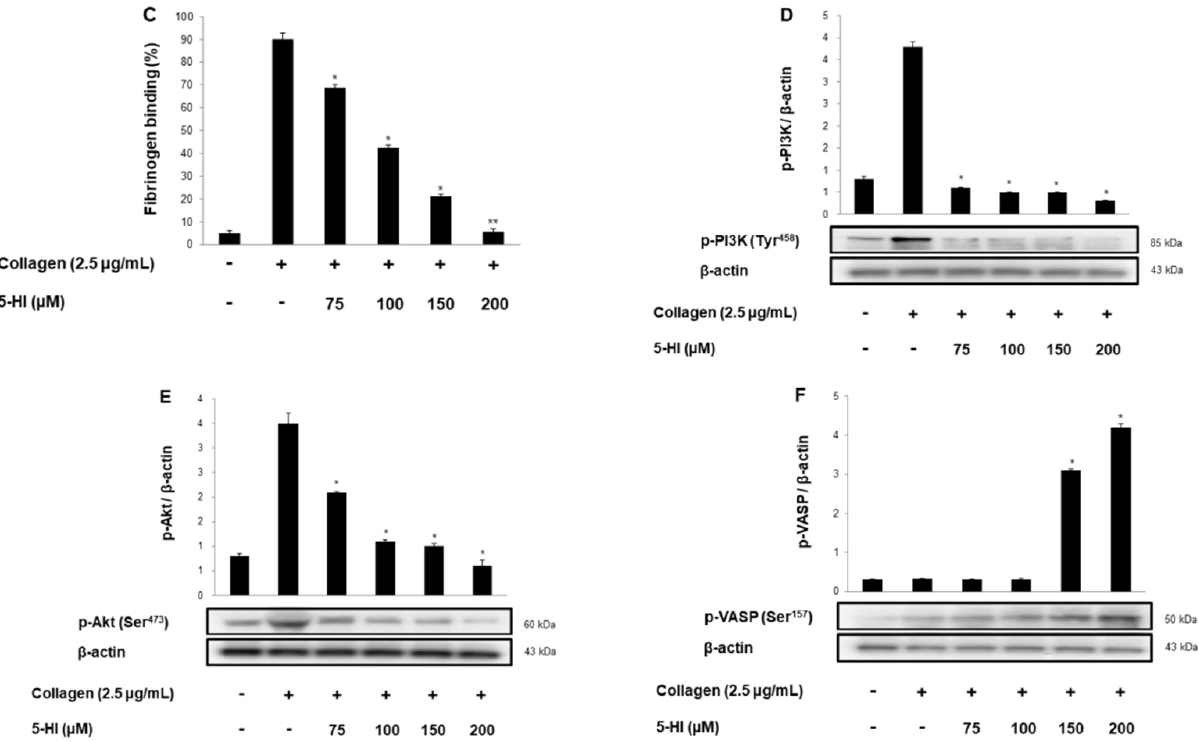
Figure 4. Effect of 5-HI on fibronectin adhesion, fibrinogen binding to α IIb/ β 3, and PI3K/Akt/VASP phosphorylation. ( A ) 5-HI’s effect on collagen-induced fibronectin adhesion. ( B ) The flow cytometry histograms on fibrinogen binding. ( a ), intact platelets (base); ( b ), collagen (2.5 μ g/mL); ( c ), collagen (2.5 μ g/mL) + 5-HI (75 μ M); ( d ), collagen (2.5 μ g/mL) + 5-HI (100 μ M); ( e ), collagen (2.5 μ g/mL) + 5-HI (150 μ M); ( f ), collagen (2.5 μ g/mL) + 5-HI (200 μ M). ( C ) 5-HI’s effect on collagen-induced fibrinogen binding (%). ( D ) 5-HI’s effect on collagen-induced PI3K (Tyr 458 ) phosphorylation. ( E ) 5-HI’s effect on collagen-induced Akt (Ser 473 ) phosphorylation. ( F ) 5-HI’s effect on collagen-induced VASP (Ser 157 ) phosphorylation. All experiments were performed as described in “Materials and Methods” section. The data are expressed as the mean ± standard deviation (n = 4). * p < 0.05, ** p < 0.01 versus the collagen-stimulated human platelets.